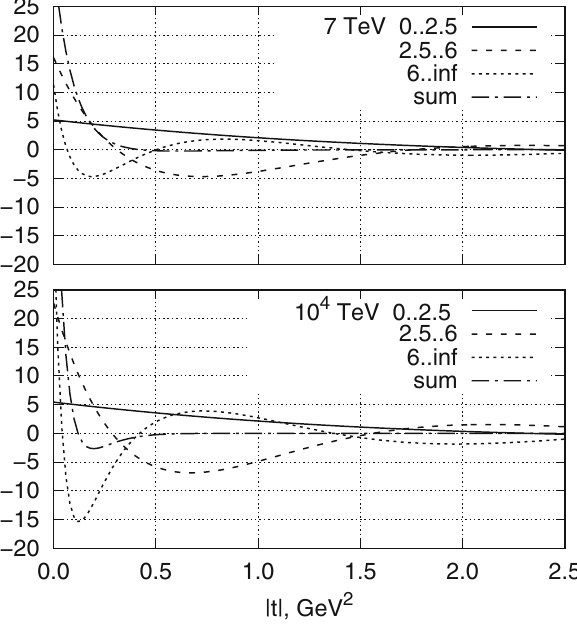
Fig. 5 The shapes of the imaginary part as a function of the transferred momentum at 7 TeV (up) and 10 4 TeV (below) are shown by the dash- dottedlines.Thecontributionstothemfromdifferentimpactparameters are also